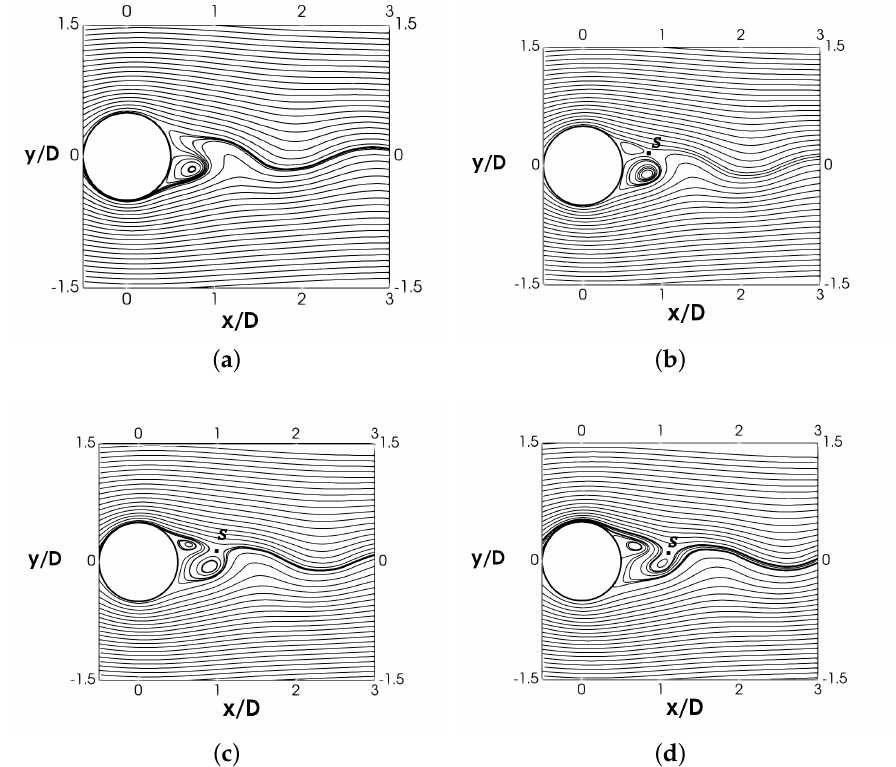
Figure 15. Phase-averaged streamlines. ( a ) φ = 0, ( b ) φ = π /4, ( c ) φ = π /2, ( d ) φ = 3 π /4. The location of the saddle point is also marked.